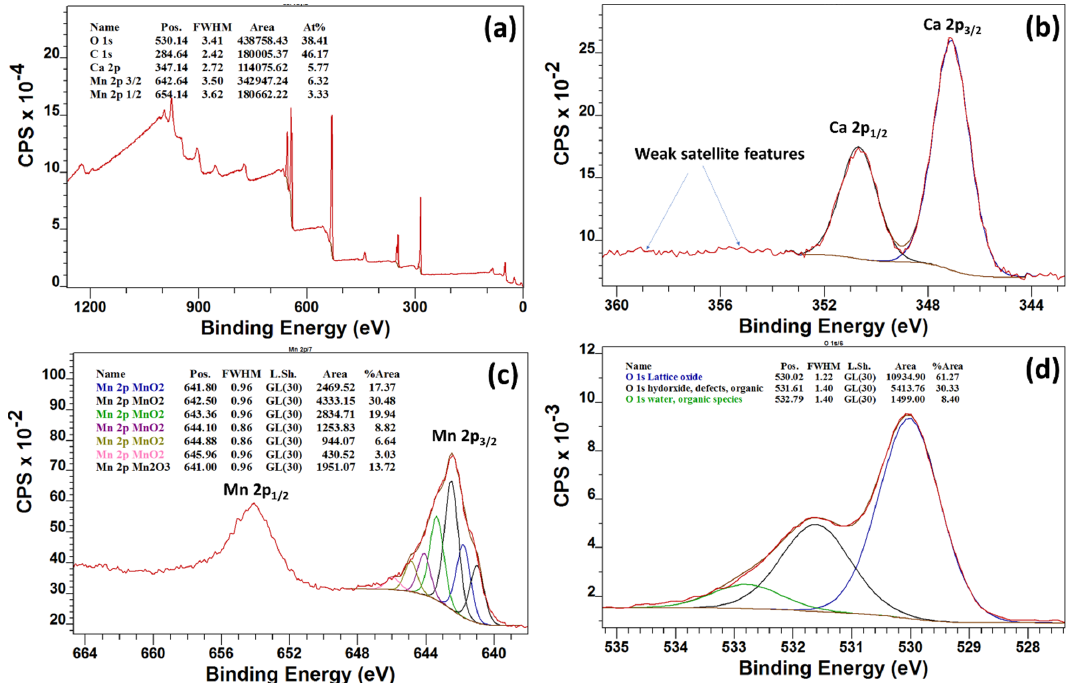
Figure 4. ( a ) Survey, ( b ) Ca 2p, ( c ) Mn 2p and ( d ) O 1s of Ca x MnO y samples. The valence band (VB) XPS was utilised to determine the VB edge for the materials as shown in Figure 5. The valence band edge position vs. Fermi level for Ca x MnO y -TiO 2 and TiO 2 were 2.62 and 2.85 eV, respectively. The shift of the VB edge to a lower value, by around 0.2 eV, indicates a band- gap narrowing which is consistent with the UV-Vis absorption spectra recorded by the authors previously [25]. Figure 5. Valence Band XPS of TiO 2 and Ca x MnO y -TiO 2 .